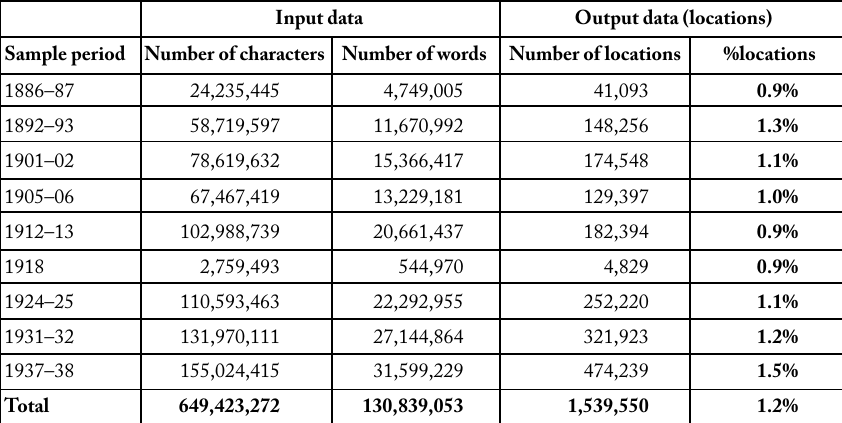
Table 3 Overview of number of words, characters, and locations in the dataset per sample period in Le